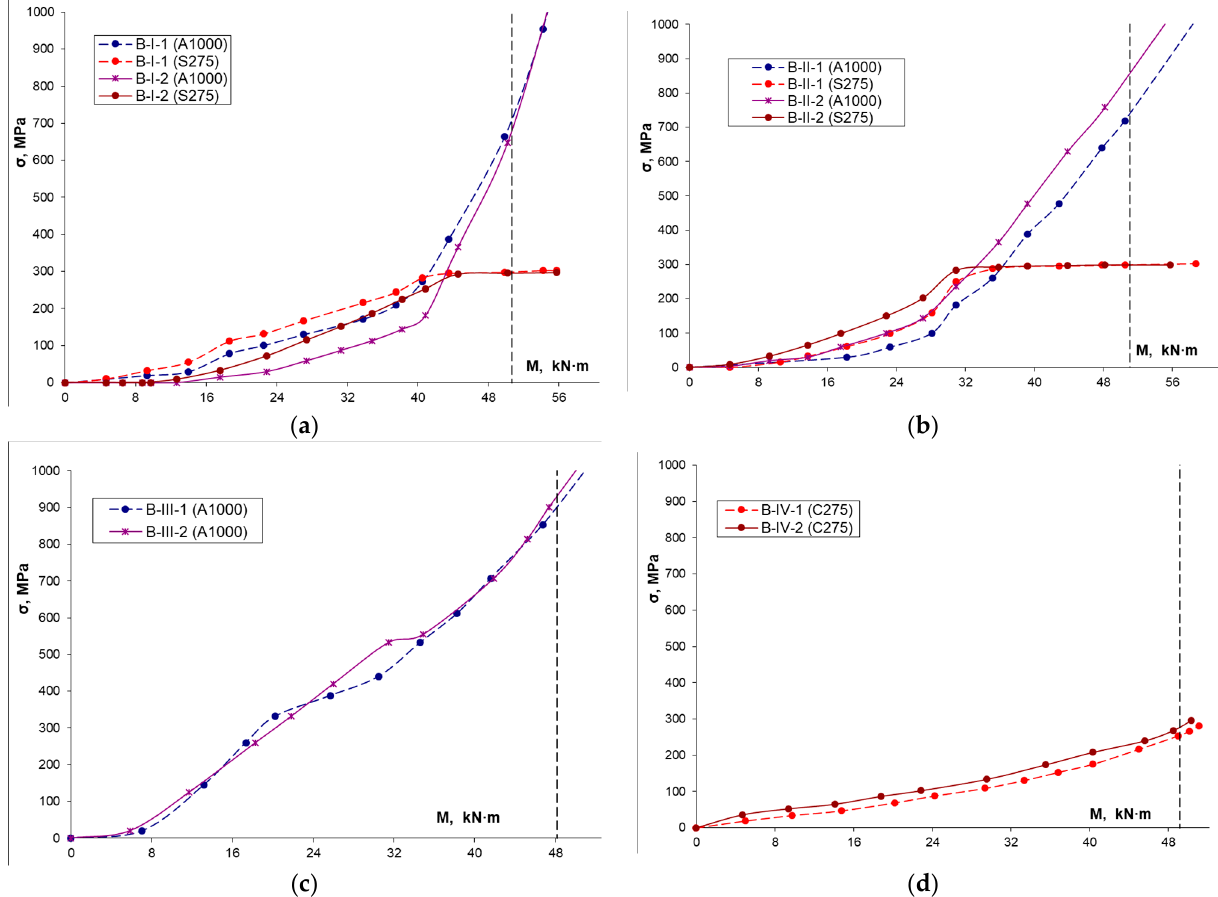
Figure 8. Graphs of stress development in the working reinforcement: ( a ) the development of stresses in stretched rebars for series B-I; ( b ) the same for series B-II; ( c ) the same for series B-III; ( d ) the same for series B-IV; X-axis indicates experimental values of bending moment M (kNm); Y-axis indicates the corresponding stress values σ (MPa). Before the beginning of the experimental investigation, the beams’ strength was calculated with the use of real σ - ε strain diagrams of reinforcement and concrete, which were used for the manufacturing of test samples. This made it possible to predict the operation of reinforced concrete beams under load with high accuracy.